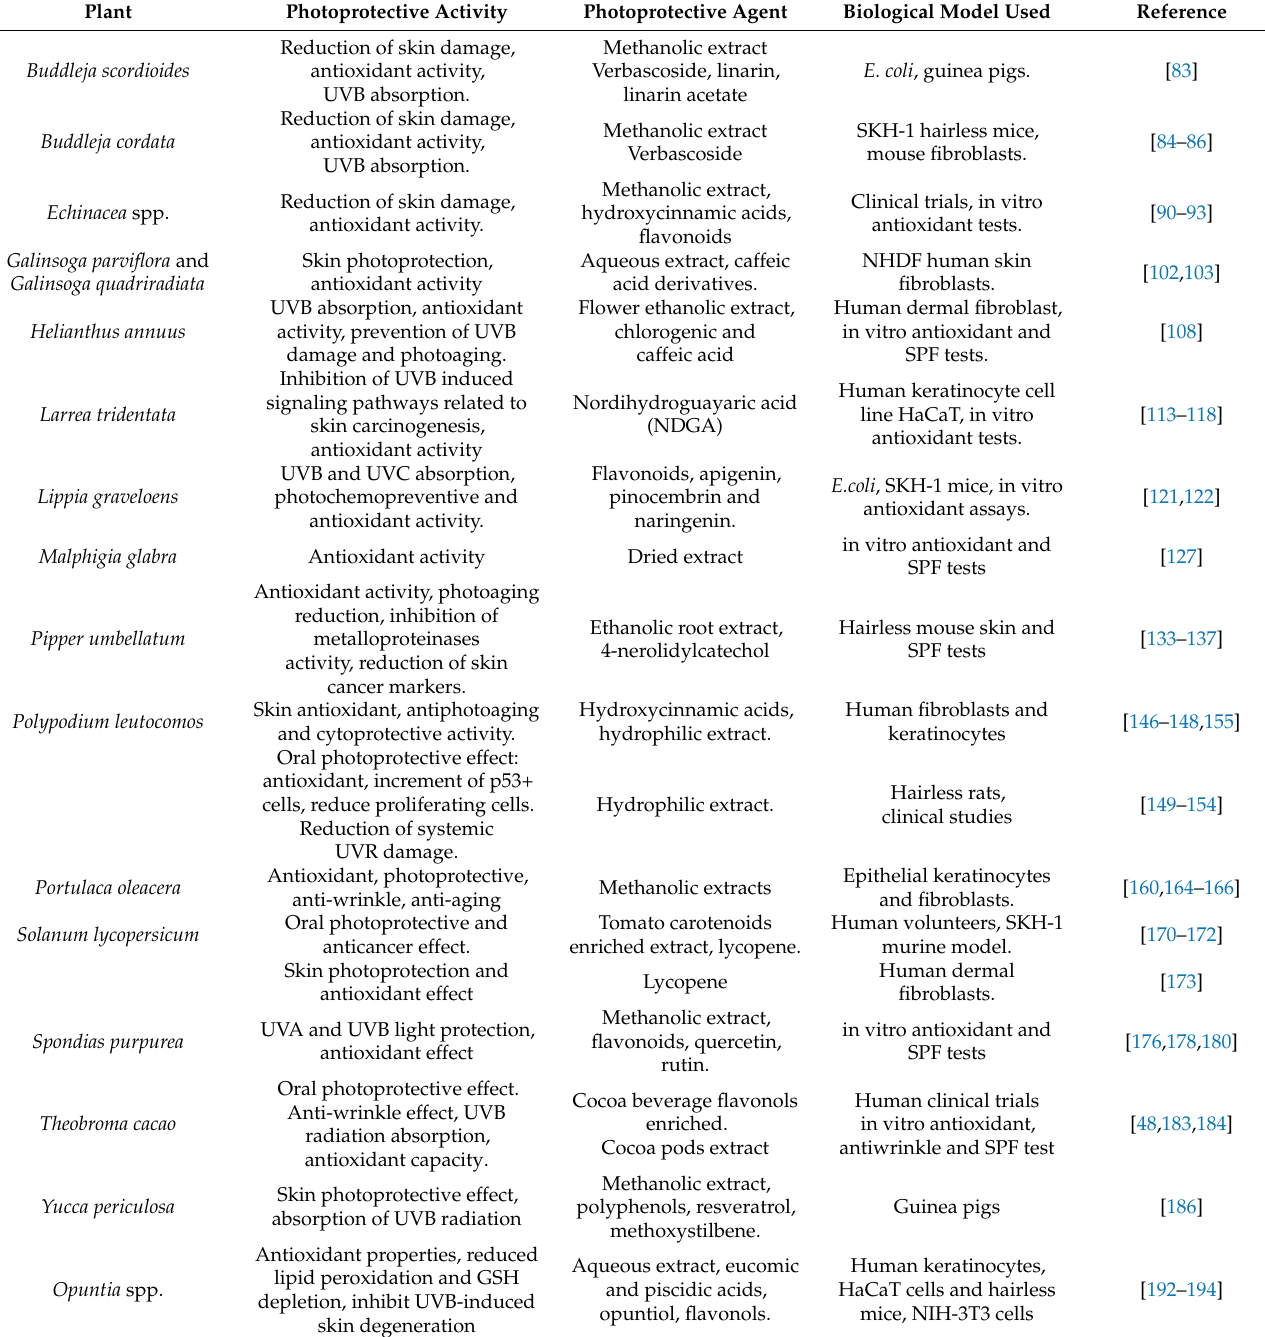
Table 2. Photo protective activities of Mexican